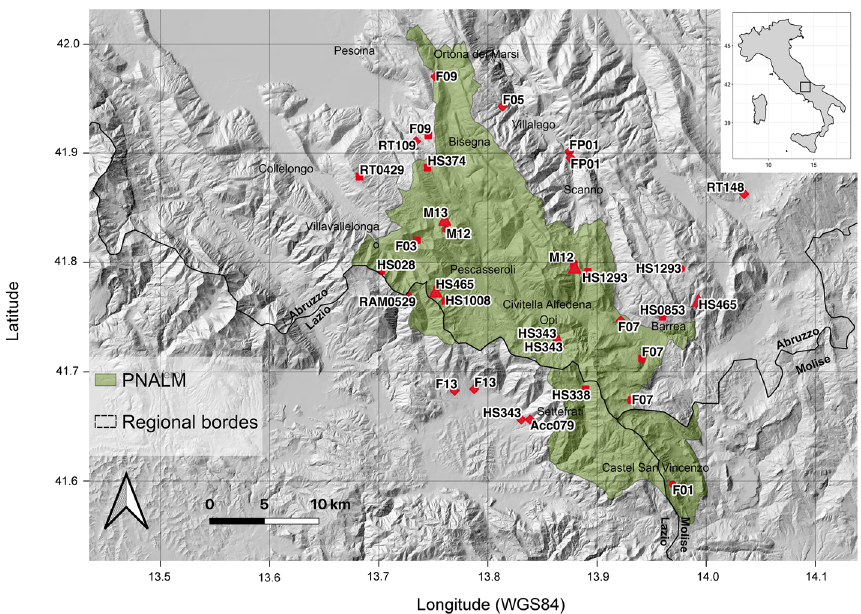
Figure 1. Distribution of 35 bear hair samples used to apply Stable Isotope Analysis to assess the assimilated diet of Apennine brown bears. Hair samples were collected through four sampling strategies (Acc: accidental sampling, HS: hair-snagging; RAM: hair snagging at Rhamnus patches; RT: hair snagging at rub trees.) during a survey of the bear population in the Abruzzo Lazio and Molise National Park (Central Italy, June–September